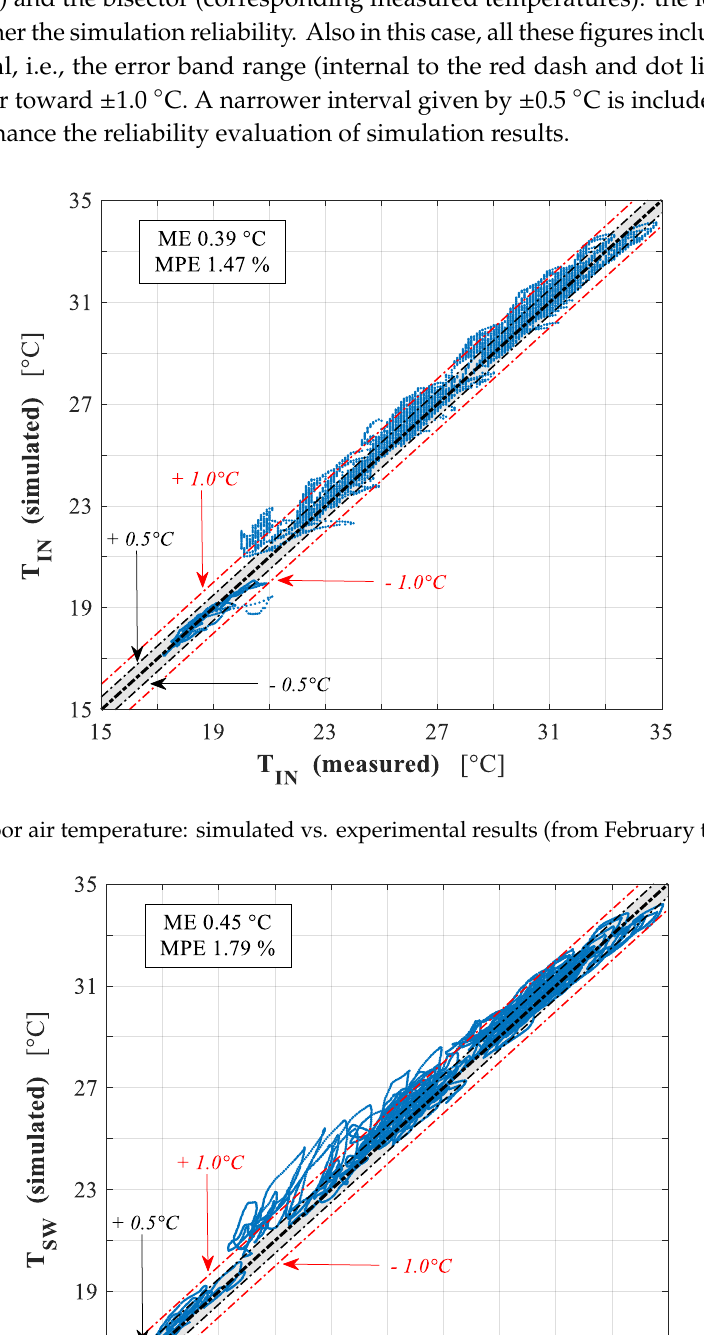
Figure 22. North-West wall temperature: simulated vs. experimental results (from February to November).